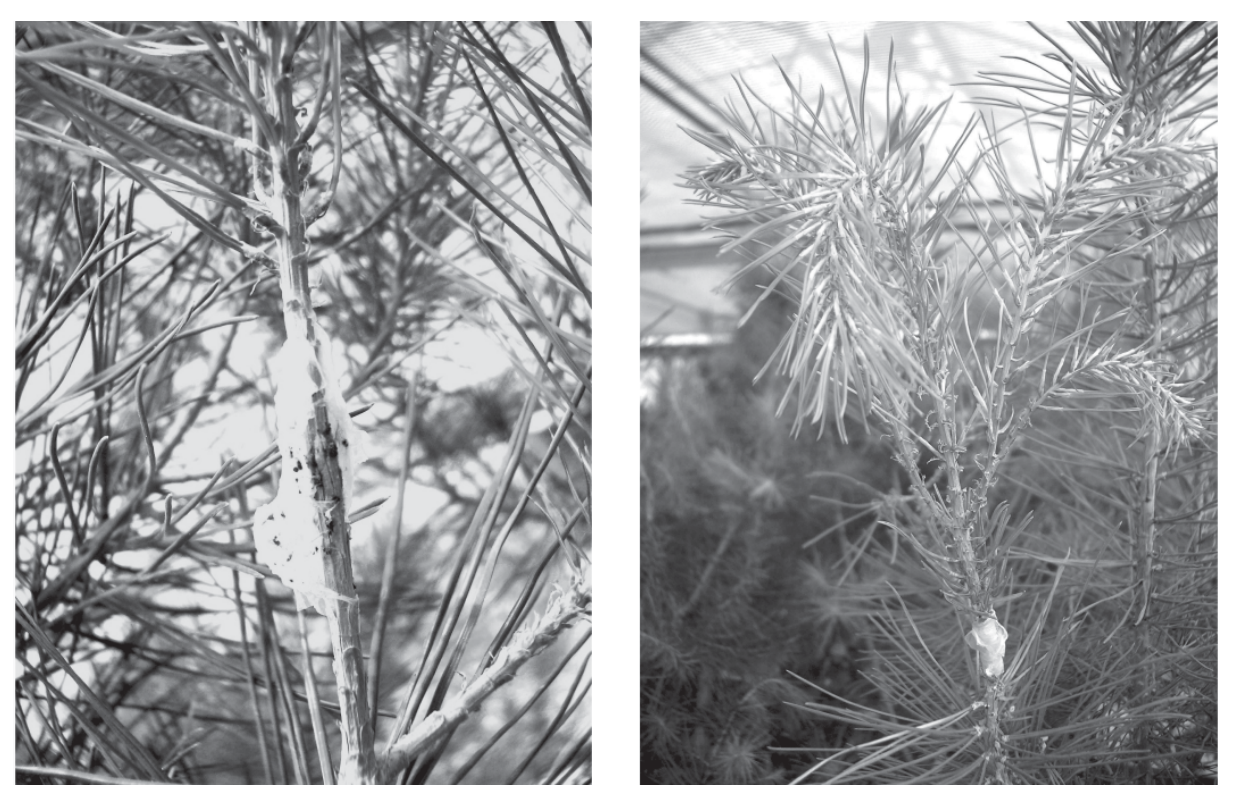
Fig. 2. Symptoms of shoot blight on Pinus halepensis two months after inoculation by Diplodia